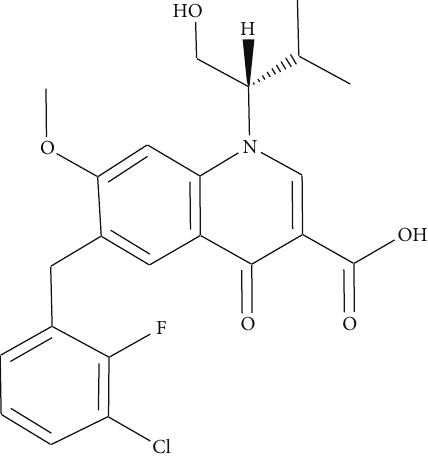
Figure 1: Chemical structure of